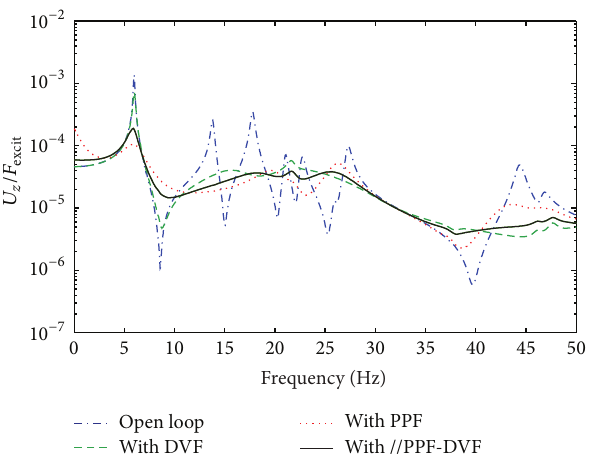
Figure 6: FRF between the force of excitation (Fexcit) and the vertical displacement of the deck ( 𝑈 𝑧 ) in point A, for different active control strategies.